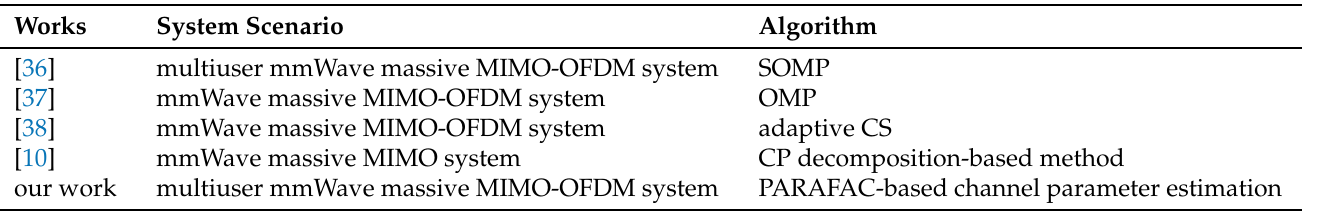
Table 1. Some reviewed channel estimation